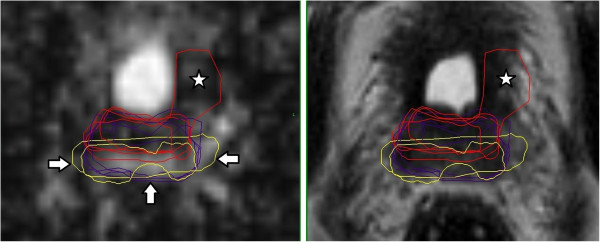
(Patient No. 5). Transversal slices through near the prostate base; left = DWI-, right = T2w-sequence. DWI based GTV-delineation (red contours) does not correspond to T2w based GTV-delineation (violet contours). Asterisk marks the erroneously contoured area in both pictures. Additionally erroneous delineation of unremarkable seminal vesicles (arrows in the left picture).